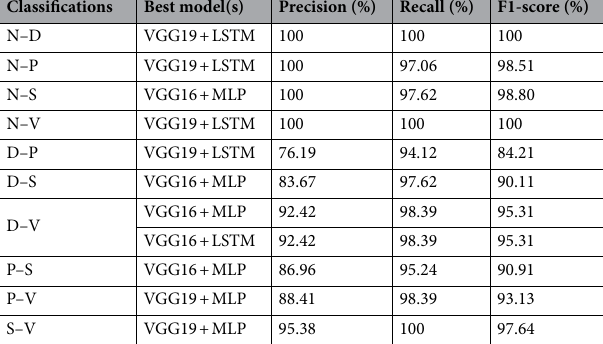
Table 10. Precision, recall, and F1-scores of the best models of ten binary classifications on AZH dataset.